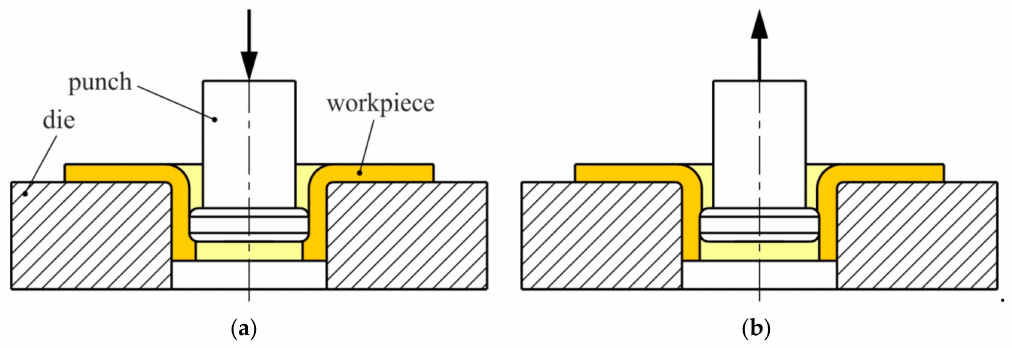
Figure 14. Schematic of the ironing process during ( a ) forward and ( b ) backward